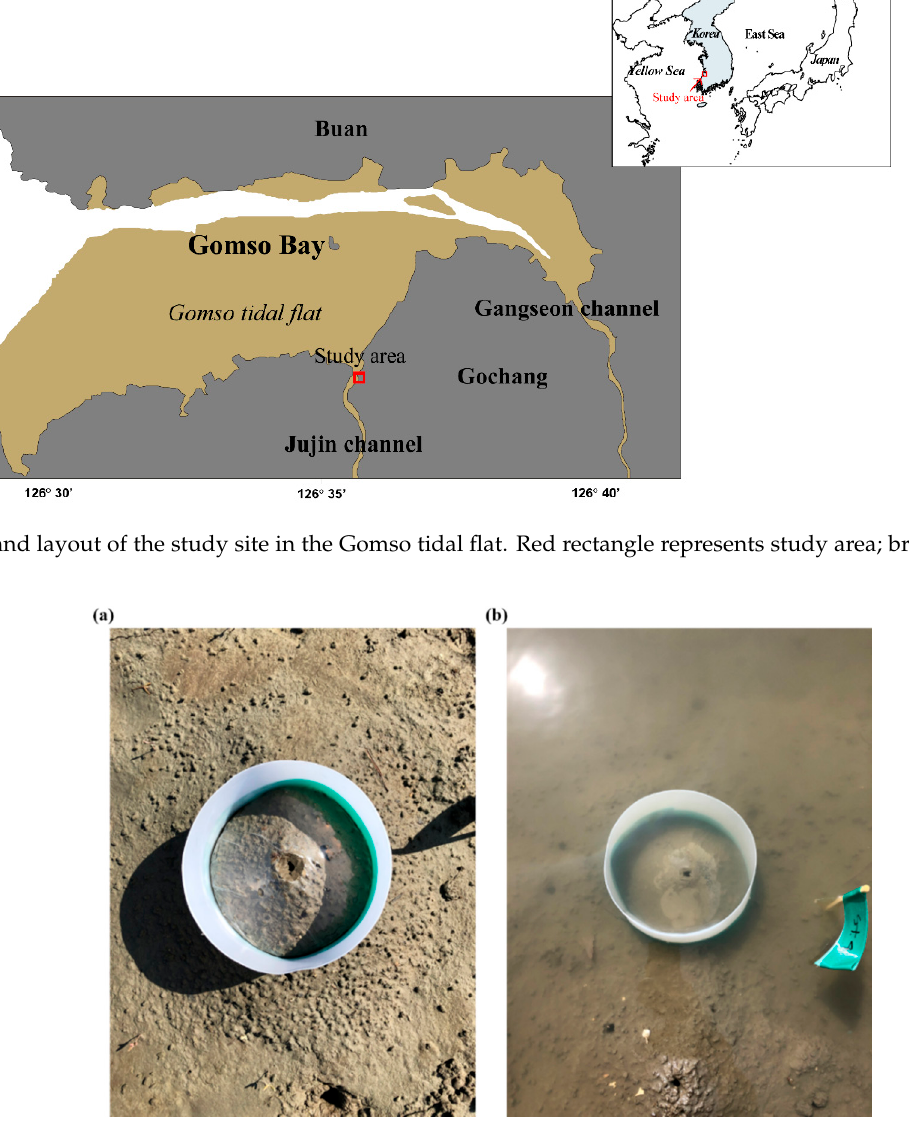
Figure 1. Location and layout of the study site in the Gomso tidal flat. Red rectangle represents study area; brown area represents tidal flat.